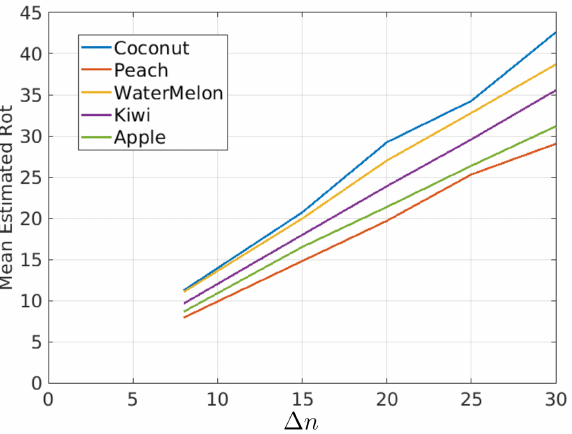
Figure 21. Mean Rotations as a function of ∆ n for different fruit types. Table 1. Mean rotations for different values of ∆ n and fruit type. Data corresponding to curves of Figure 21. Coconut